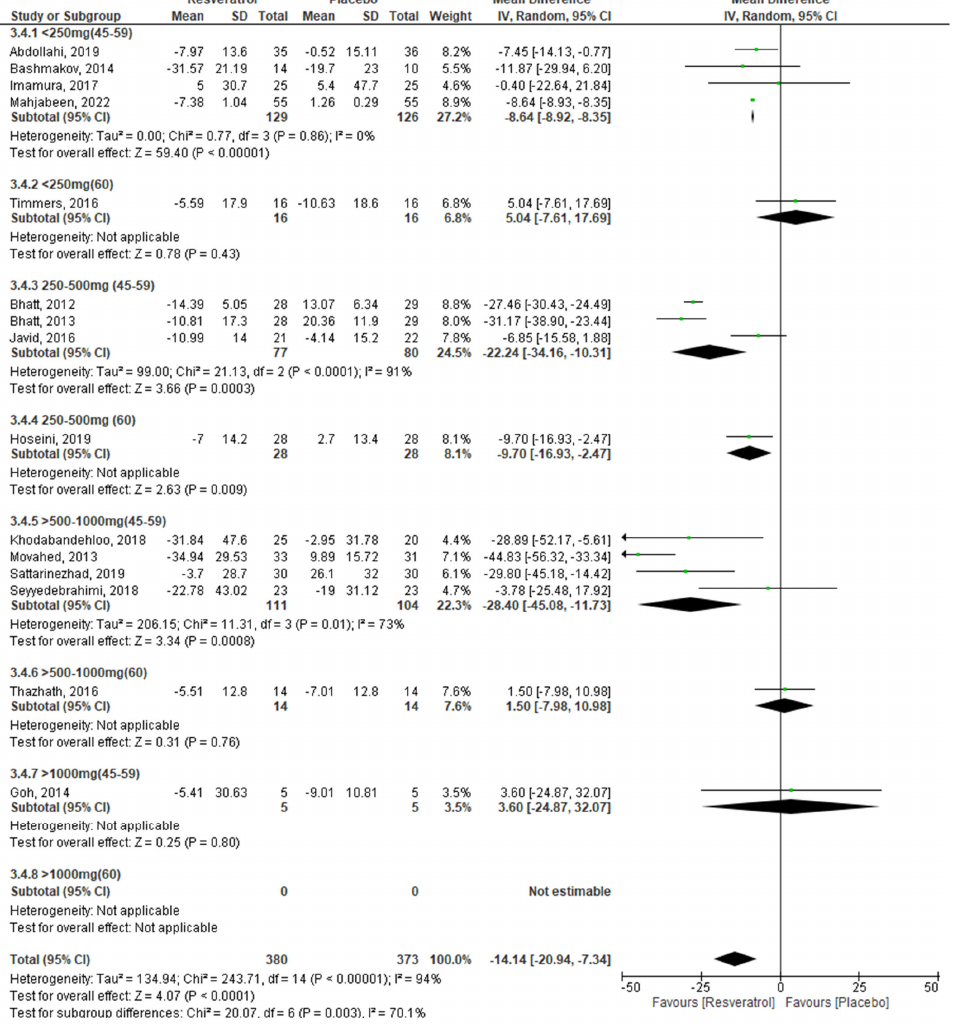
Figure 3. Effect of RV on glucose, stratified by age and dose.